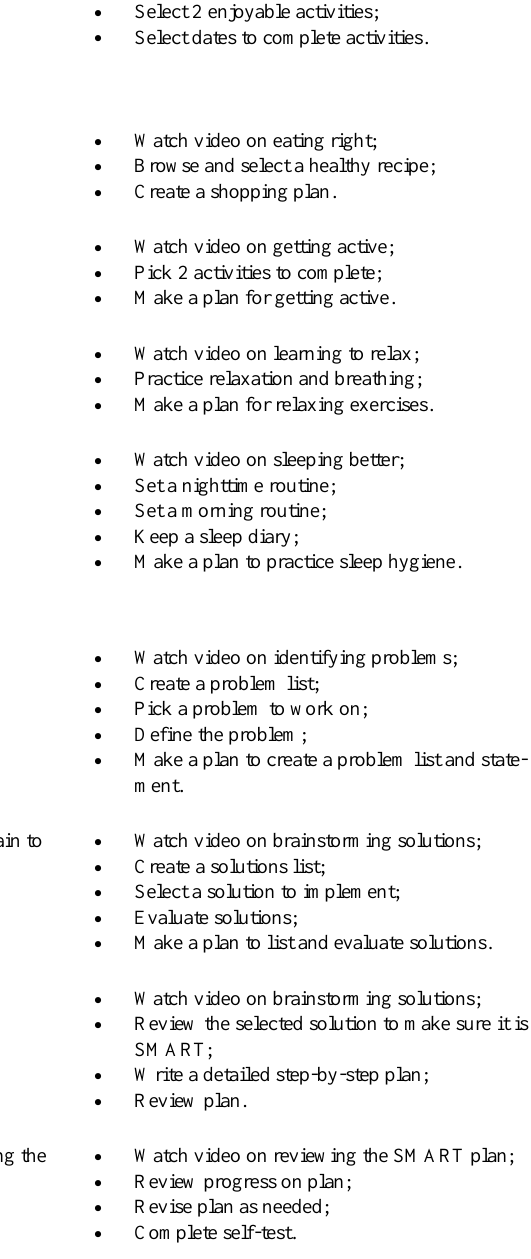
Table 1. Breakdown of participant progress through The Journal. Learn the importance of staying positive and planning regular